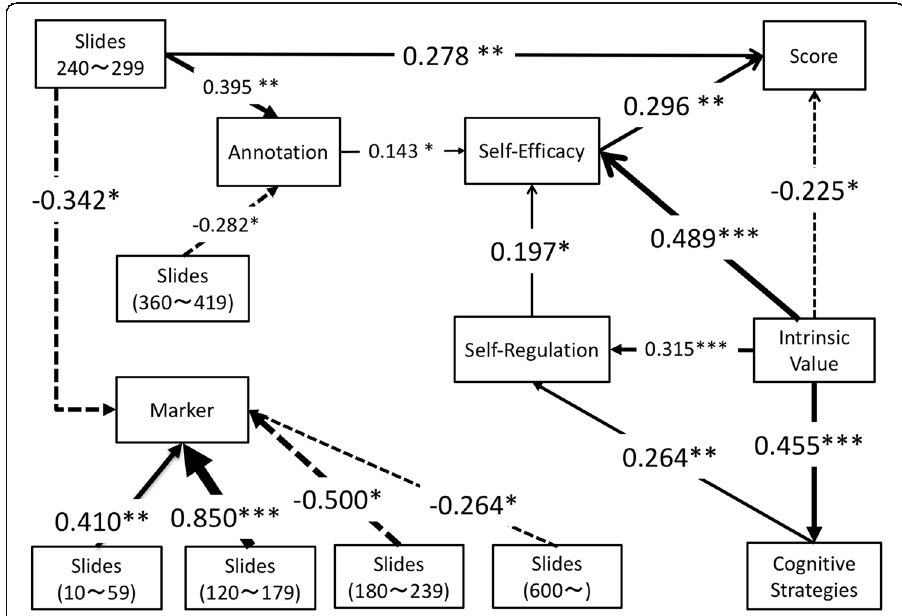
Fig. 2 The results of path